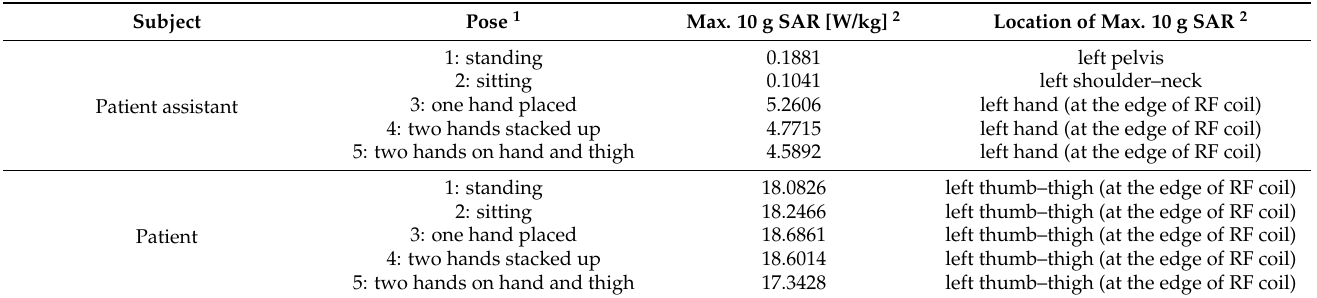
Table 2. Maximum 10-g averaged SAR values for five different poses of patient assistant and their